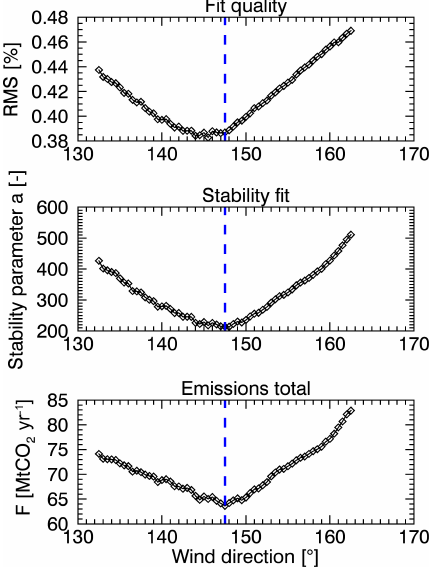
Figure 11. Sensitivity of the inverse Gaussian plume model to the wind direction for flux F , stability parameter a and the RMS be- tween measurement and